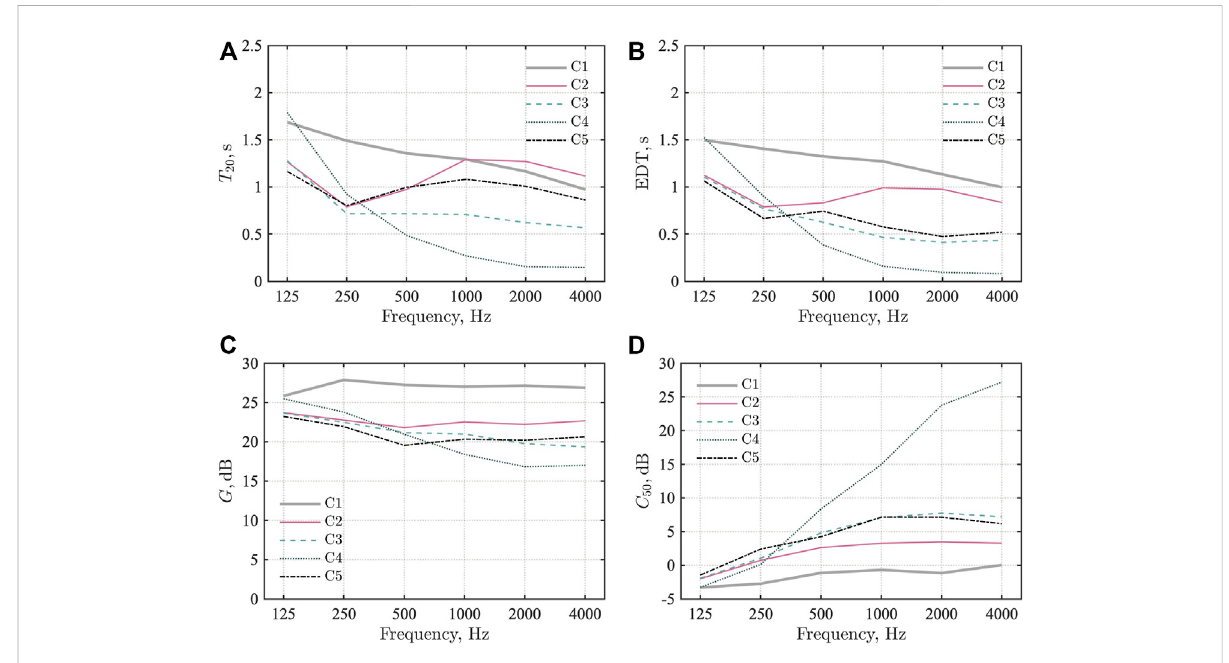
FIGURE 10 Comparison of room-acoustic parameters for cases C1 – C5: (A) T 20 , (B) EDT, (C) G , and (D) C 50 .